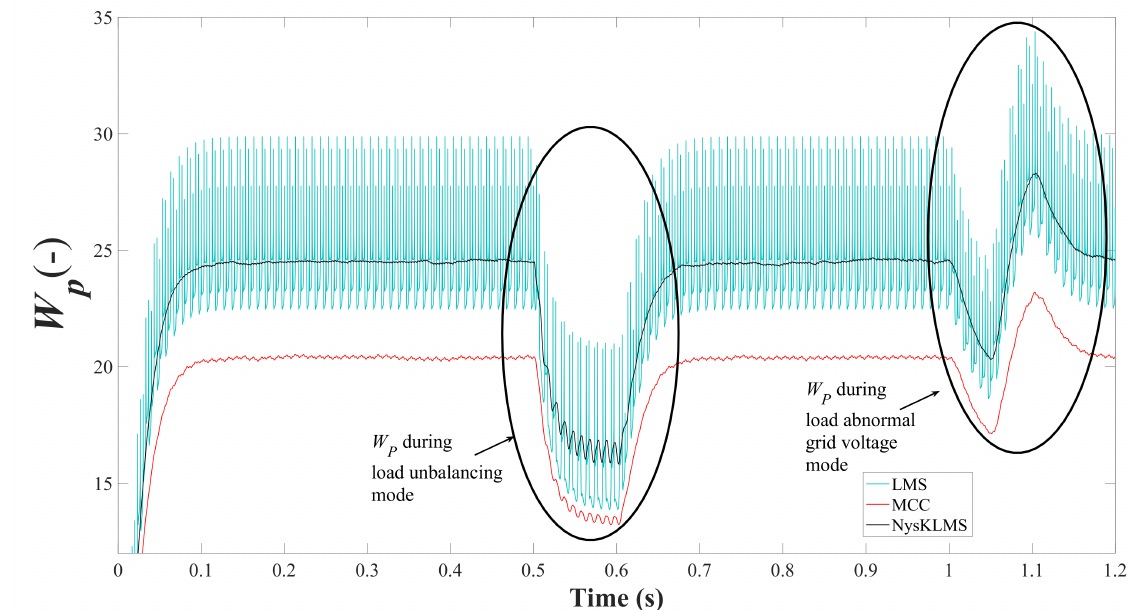
Figure 18. Comparison of W p of LMS, MCC, and NysMKRSL